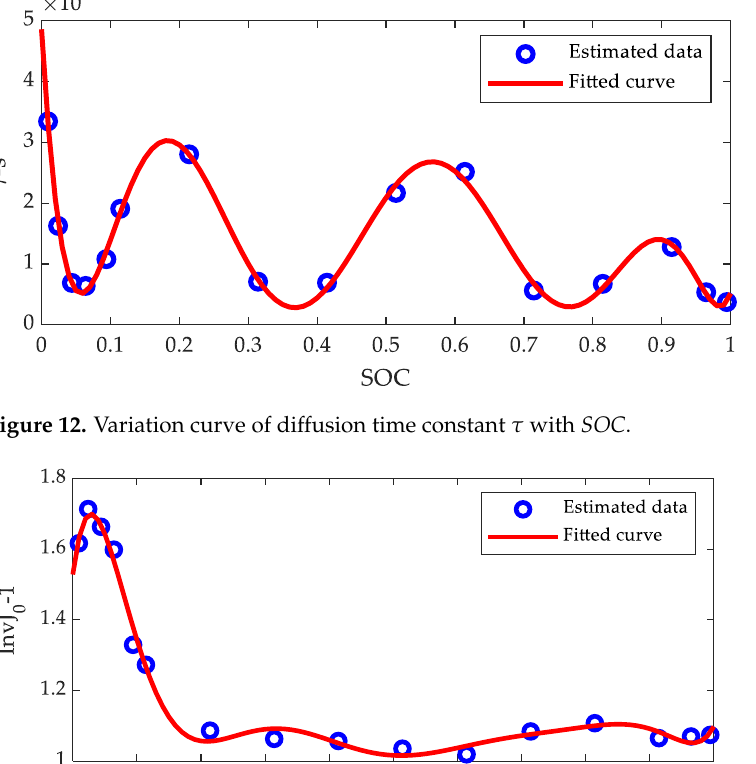
Figure 14. Variation curve of ohmic overpotential at 1 C rate η IR,1C with SOC. At an ambient temperature of 25 °C, the New European Driving Cycle (NEDC) data were used as the test data for real-time quantitative characterization of polarization volt- age based on LDM. The data were fed into the characterization platform when SOC = 0.8468 and stopped when SOC = 0.7006. Input current update frequency and terminal volt- age acquisition frequency were 1 Hz. The values of the model parameters at specific SOC level were obtained by interpolation of the previously calibrated curves. The current vs. terminal voltage curves (Figure 15), SOC curves (Figure 16), and polarization voltages (Figure 17) were plotted dynamically during cycling. Based on the hardware platform used, real-time characterization of polarization voltage drops at a frequency of 1 Hz could be achieved using the proposed method (actual calculation time consumption for each time step is less than 500 ms). The model output voltage maintained good tracking per- formance by comparing with the battery terminal voltage data obtained from the acquisi- tion board. However, it was observed that the voltage tracking error increased when the current increased. The possible sources of error are 1) LDM does not include the electro- lyte concentration polarization, 2) errors from the identification algorithm or the curve fitting, which are expected to be further improved. It can be seen that the voltage drop from all three types of polarization was positively correlated with the current applied to the cell, which is consistent with the findings of previous studies [14,17,49]. In summary, the proposed method achieves the function of quantitative characterization of polariza- tion voltage, and the algorithm computation efficiency can meet a good real-time perfor- mance.